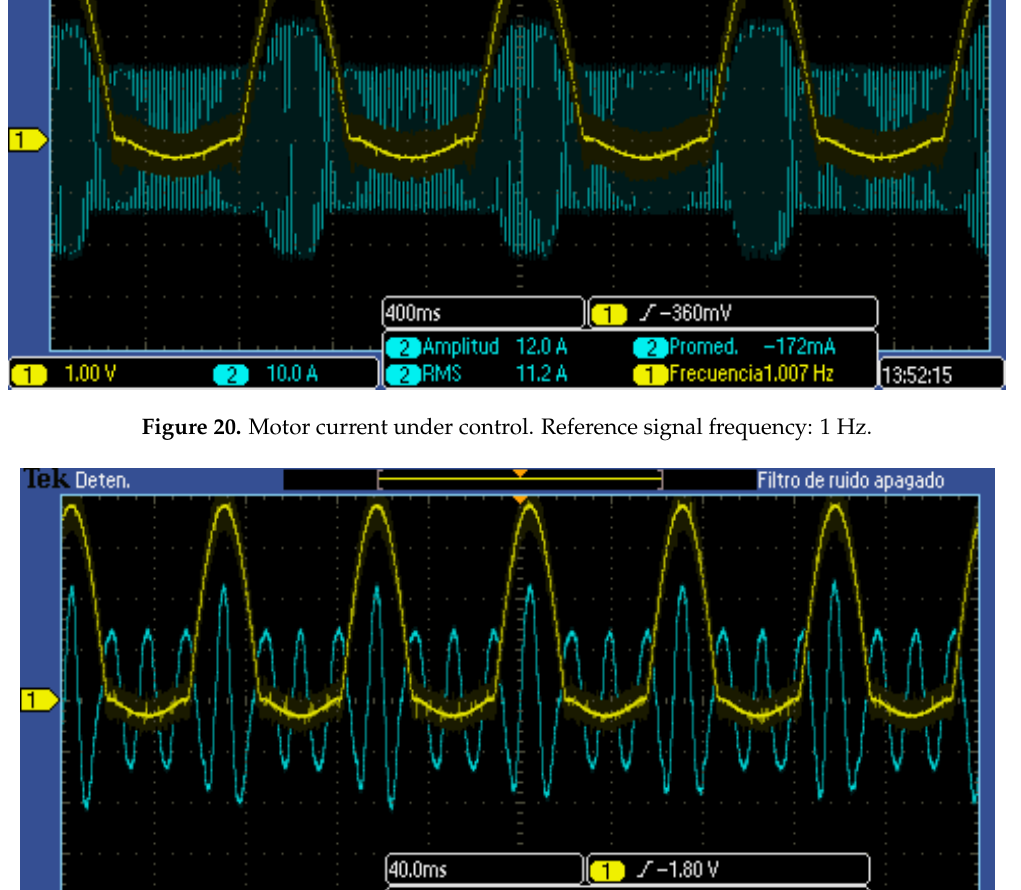
Figure 21. Motor current under control. Reference signal frequency: 10 Hz